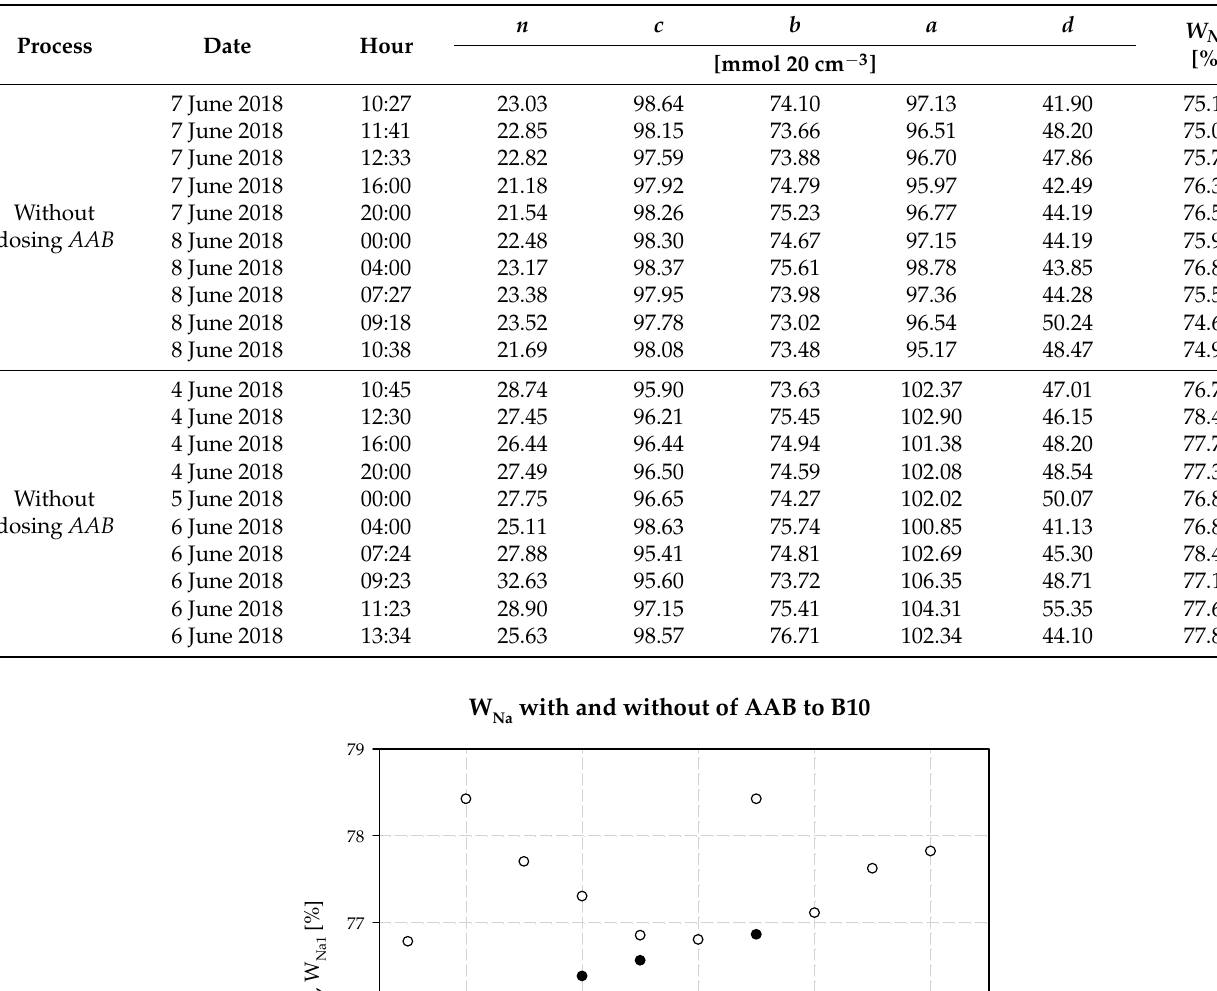
Table 3. Selected results with and without dosing AAB to carbonization column.